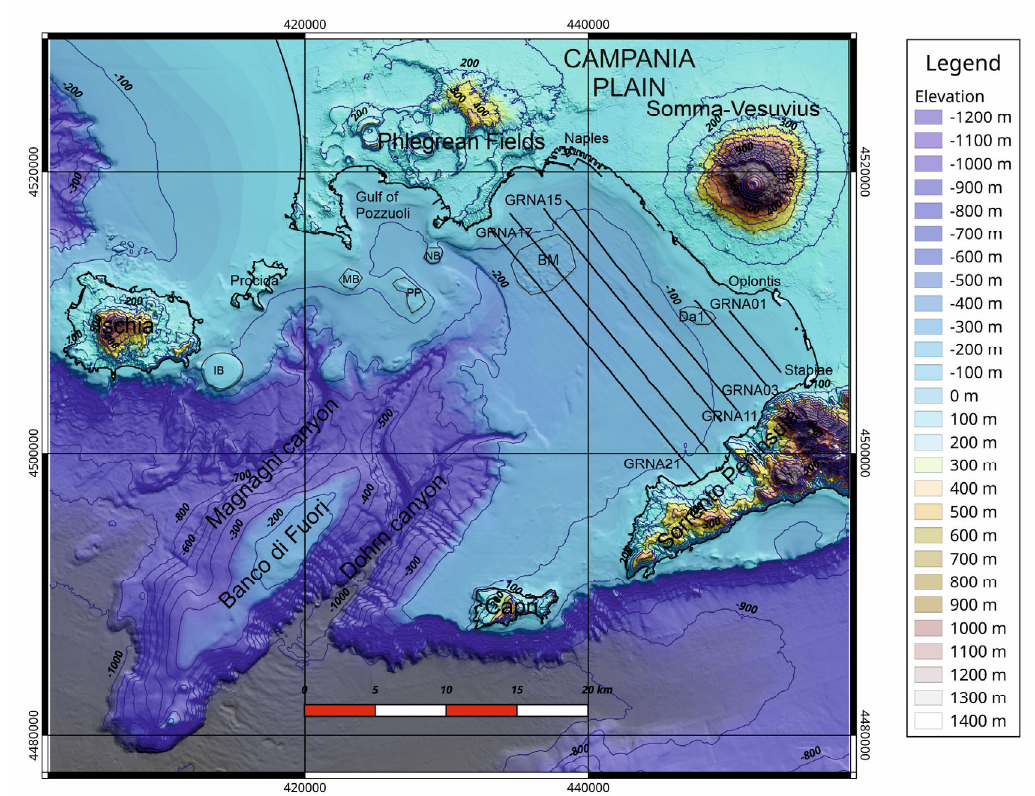
Figure 1. Sketch map showing the location of the seismic profiles superimposed on the Multibeam bathymetric map of Naples Bay. The main morpho-structural features of the Bay of Naples are also reported (Dohrn canyon, Magnaghi canyon, Banco di Fuori). Da1: debris avalanche; BM: Banco della Montagna; NB: Nisida Bank; PP: Pentapalummo Bank; MB: Miseno Bank; IB: Ischia Bank.